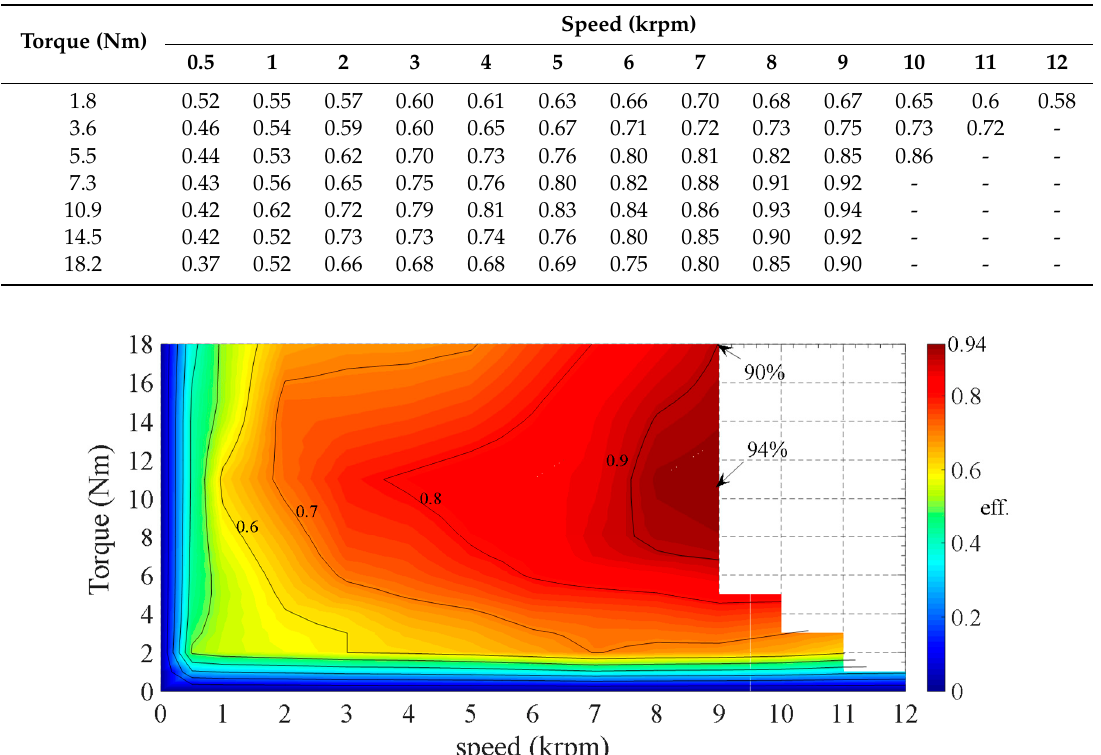
Table 9. Torque, speed, and e ffi ciency map of the developed prototype.